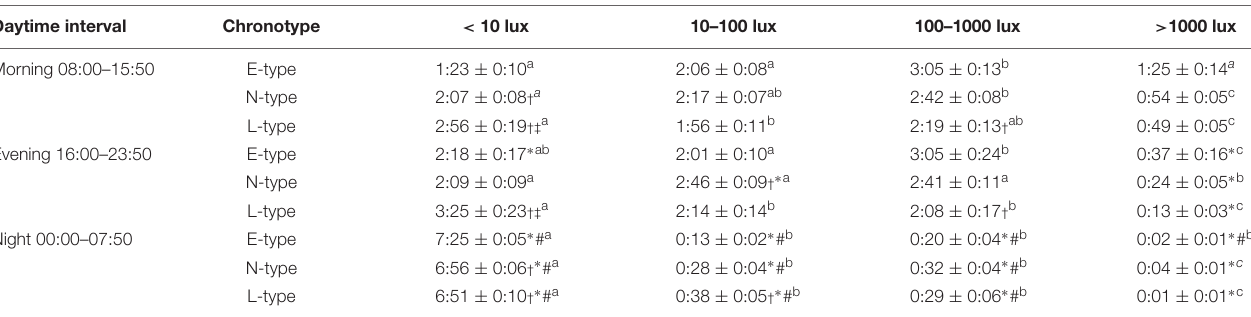
FIGURE 1 | Mean waveforms and actograms for early (E-types, in yellow; n = 20% of total subjects), neither (N-types, in dotted black; n = 60% of total subjects), and late-types (L-types, in blue; n = 20% of total subjects) for: (A) light exposure (L; total subjects = 137) and (B) environmental temperature (ET; total subjects = 137). Waveform data are expressed as mean ± SEM. Plotted actograms correspond to the first tercile values (values corresponding to the rest phase). TABLE 3 | Duration and intensity of light exposure by chronotype and daytime